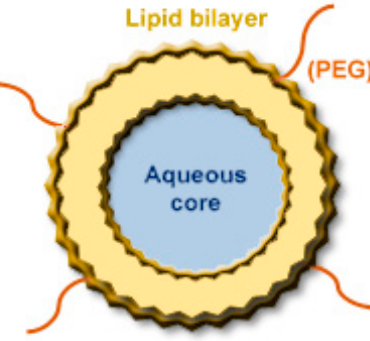
Figure 6. Scheme of a typical PEGylated liposome [158].